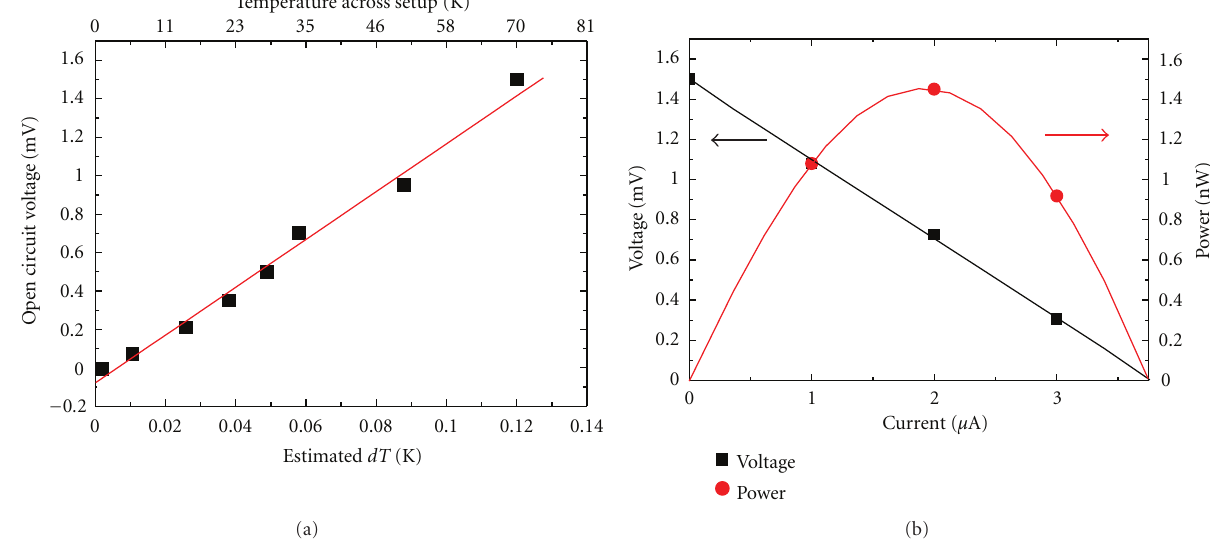
Figure 25: (a) Plot of the TEG’s V oc versus the di ff erent dT (actual/estimated) applied across it. A best fit line is drawn through all the data points. (b) Voltage/Power versus Current curve when dT (estimated) is 0.12K with V oc and I sc of 1.5 mV and 3.79 μ A, respectively. The black line is a linear fit and the red line a polynomial fit of the data points. (Reprinted with permission from [70]. [2011]